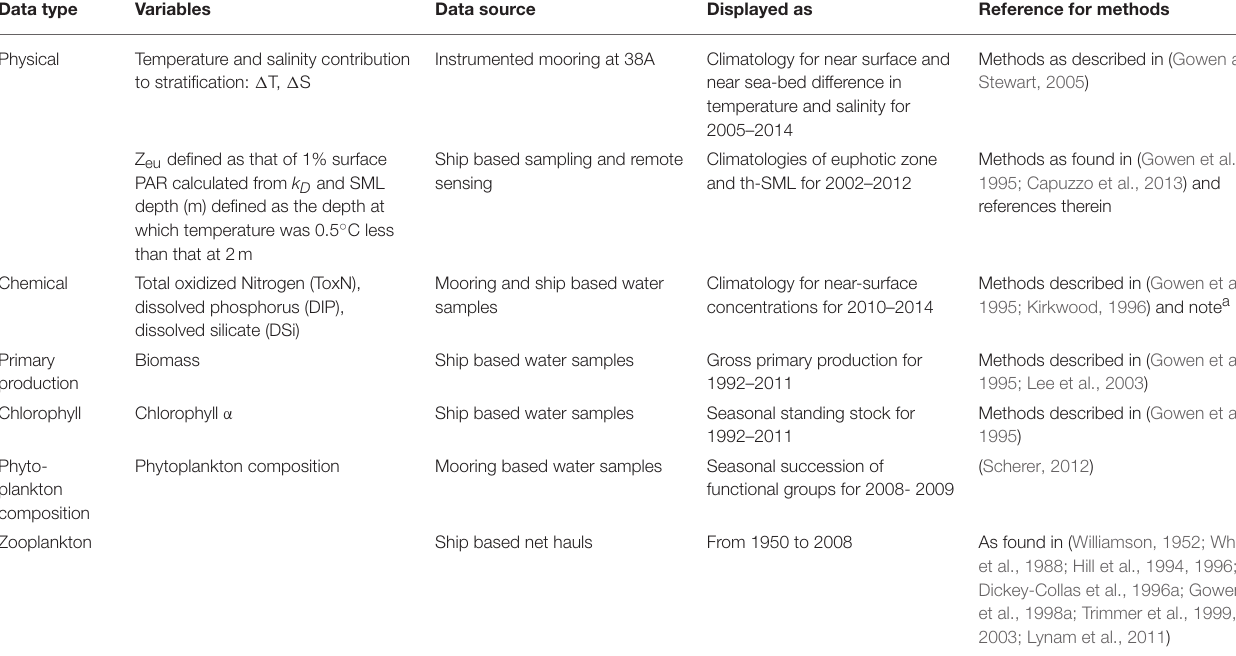
TABLE 3 | Summary of methods; methods used for analysis of data mainly derived from AFBI core monitoring programs and from EFF-funded surveys in